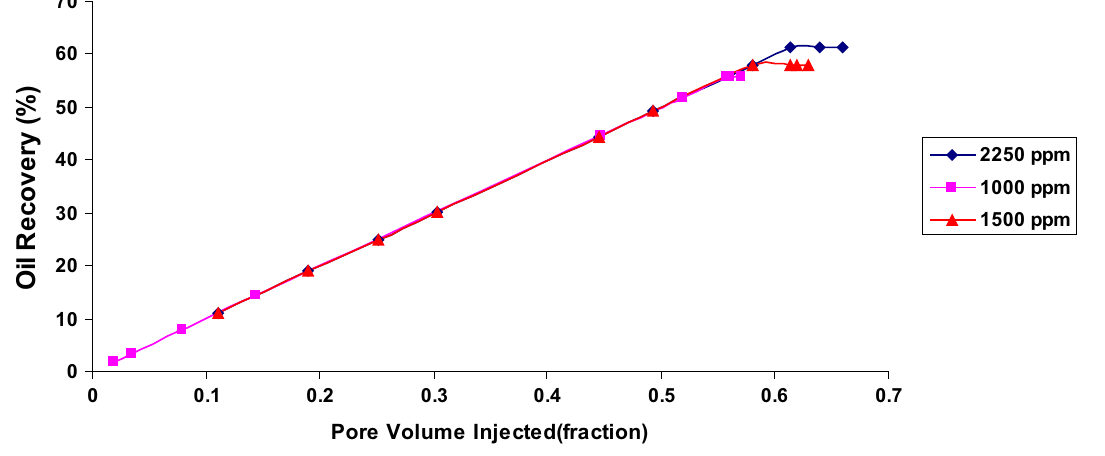
Fig. 5 Comparison between oil recoveries by three different concentrations of polymer solutions of polymer type 1 (flow rate = 0.0002 cc/min)